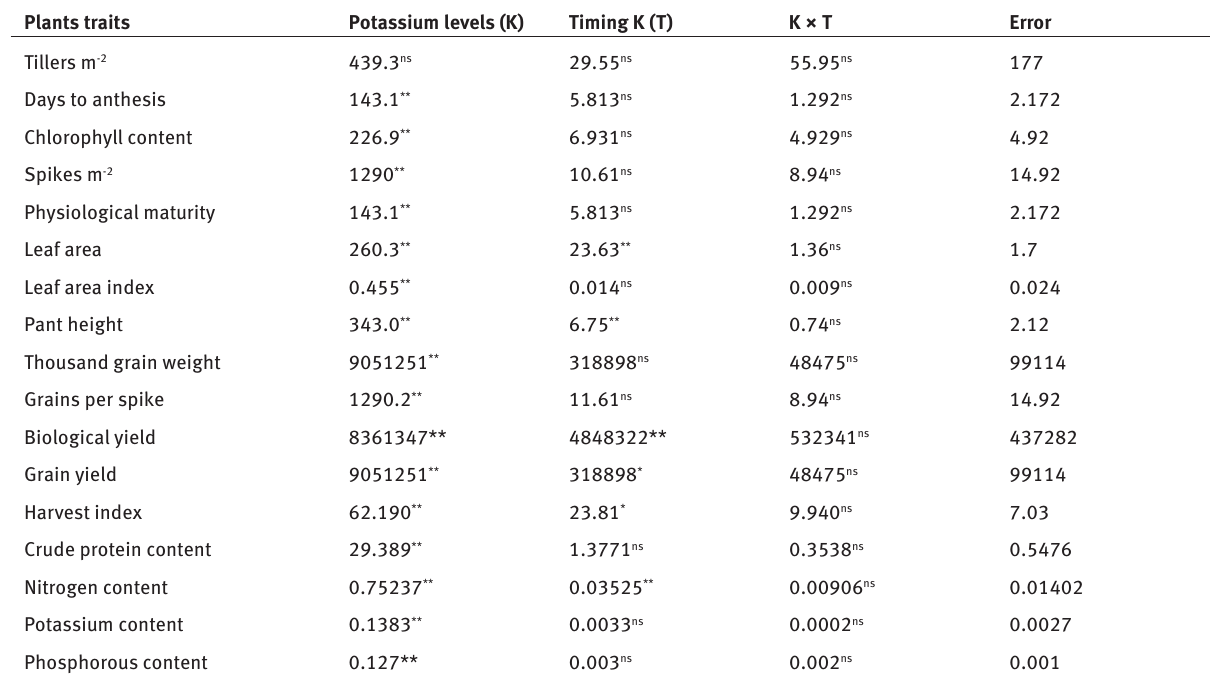
Table 1: Mean square values of phonological, physiological, yield, yield components and grain nutrients contents of wheat as influenced by K levels and application timings